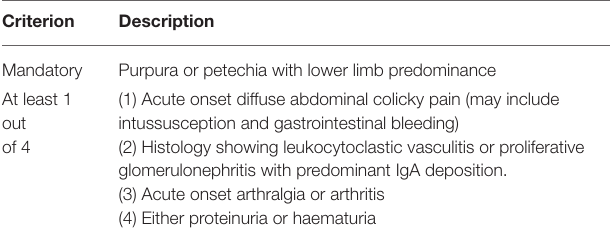
TABLE 2 | The EULAR/PReS/PRINTO classification criteria for childhood IgA vasculitis.